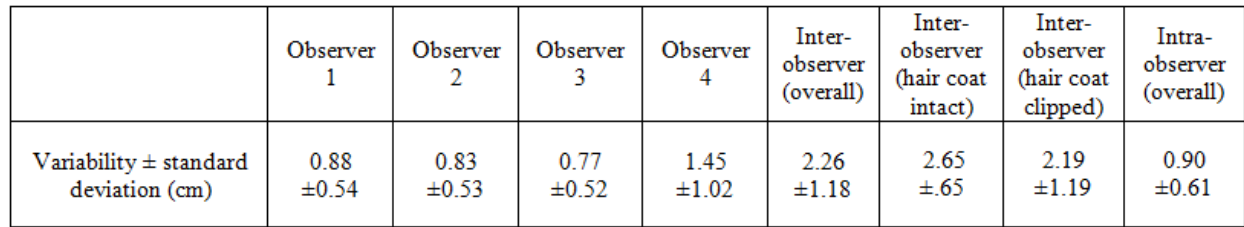
Table 1 : Phase 1 Cadaveric data - Inter- and intra-observer variability of TC measurement (in cm) for measurements at all different inflation levels combined